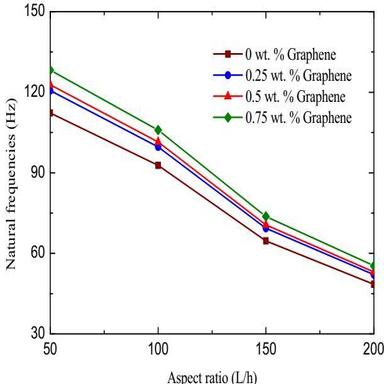
The effect of aspect ratios on the natural frequencies of GFRP composite panels with various wt% of graphene reinforcement under CFCF end conditions.